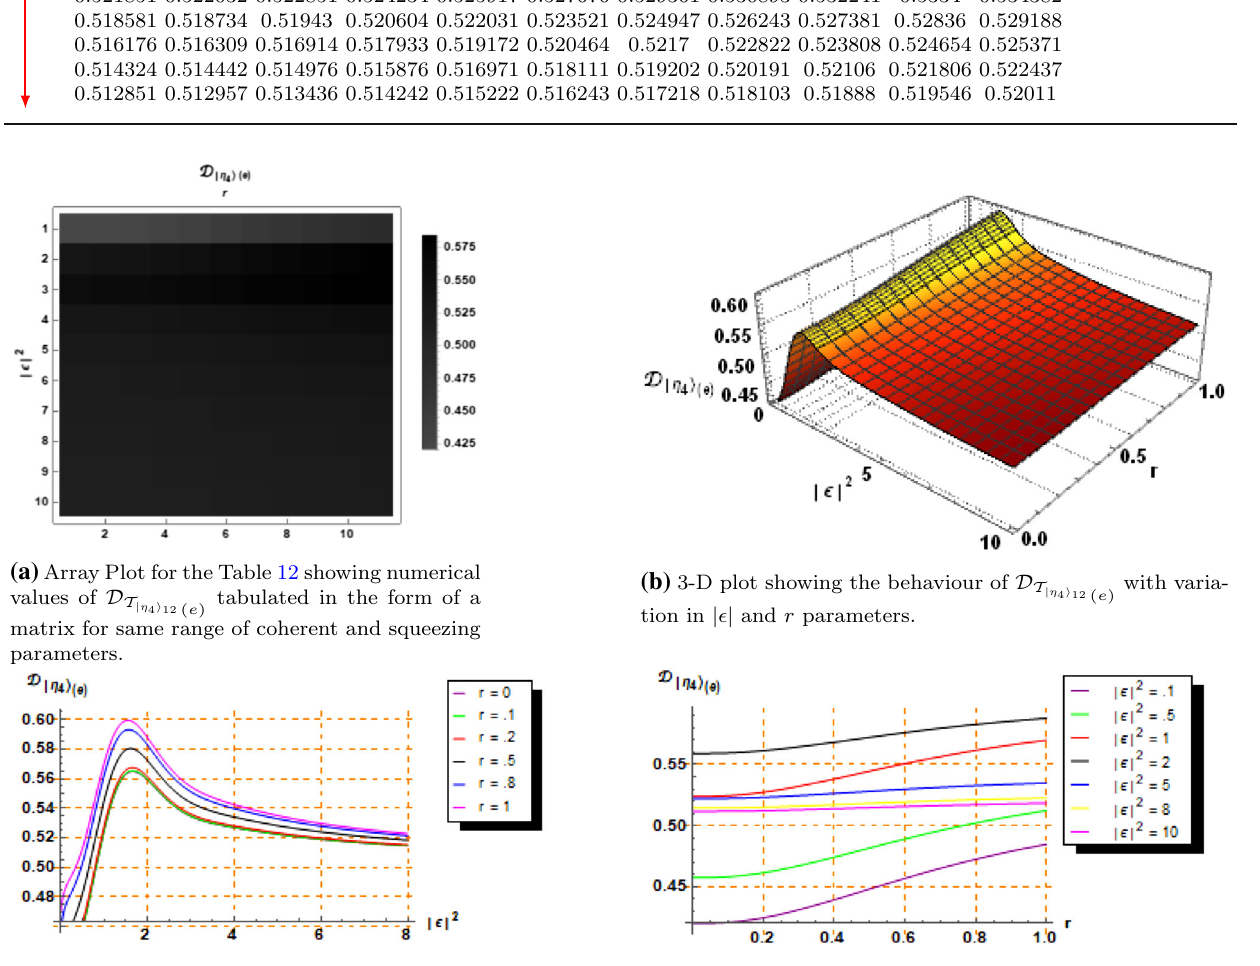
eter for fixed values of squeezing parameters. Here, with the increasing values of coherent parameter the nonclassical char- acter of the | η 4 (cid:2) starts decreasing and then become